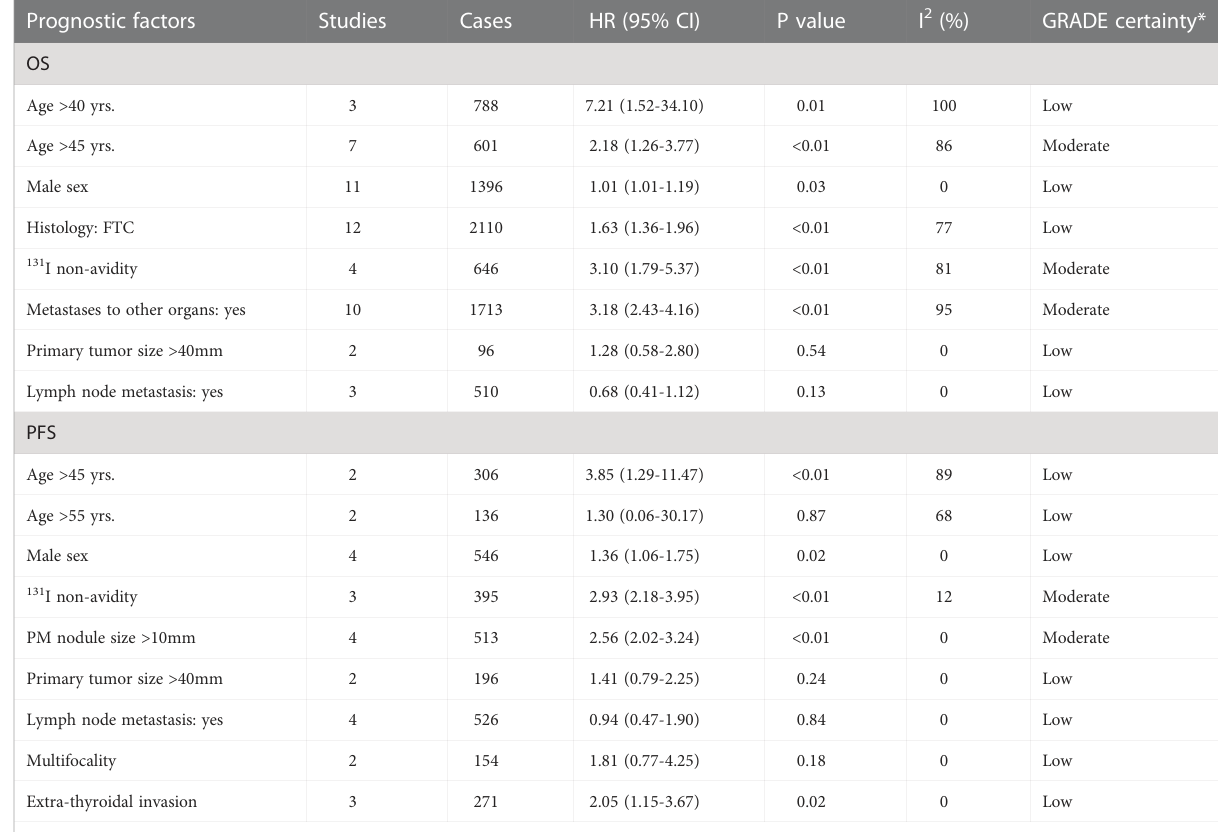
TABLE 1 Prognostic factors and associated hazard ratio of survival. Prognostic